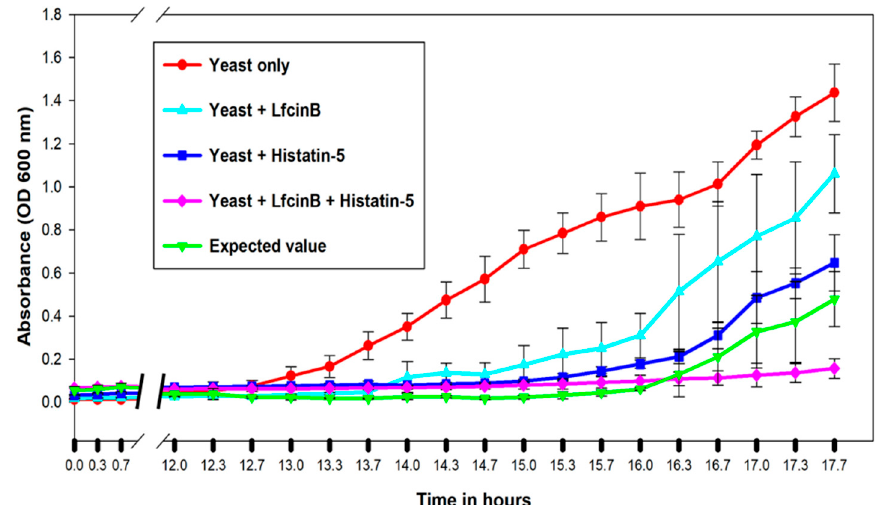
Figure 8. Growth inhibition e ff ect of individual and combination of Lfcin B and Histatin-5 on yeast. Yeast was grown without AMPs and in the presence of individual and combination of Lfcin B (15 µ g / mL) and Histatin-5 (20 µ g / mL). Significant inhibition in growth was observed with the combination of Lfcin B and Histstin-5. The combinational inhibition of Lfcin B and Histatin was significantly lower than the expected value of Lfcin B and Histatin-5 combination calculated from the individual inhibition of Lfcin B and Histatin-5, concluding the synergy combination between Lfcin B and Histatin-5.